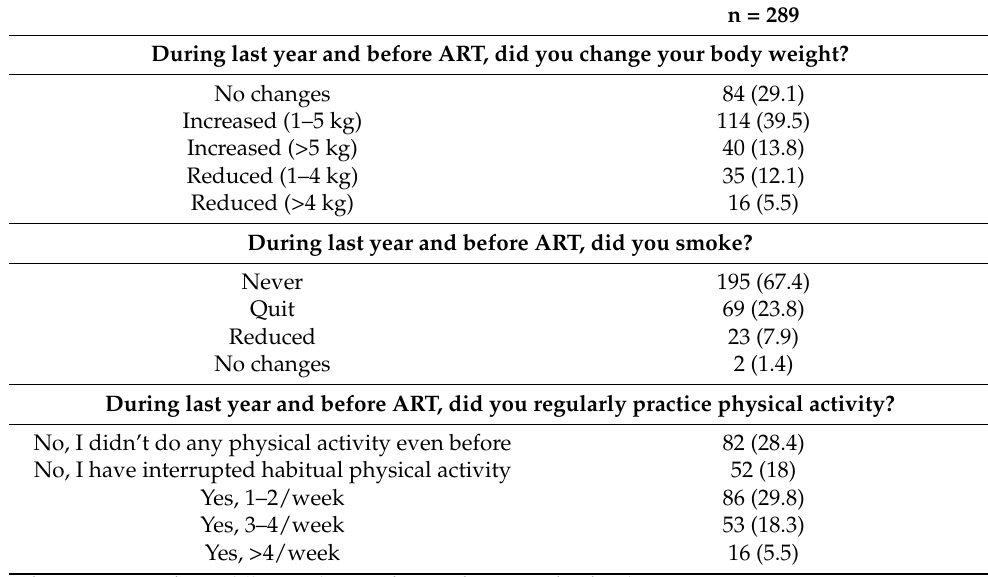
Table 2. Lifestyle changes during COVID-19 pandemic.